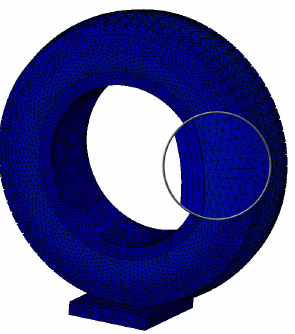
Figure 4. The tyre–road finite element mesh.